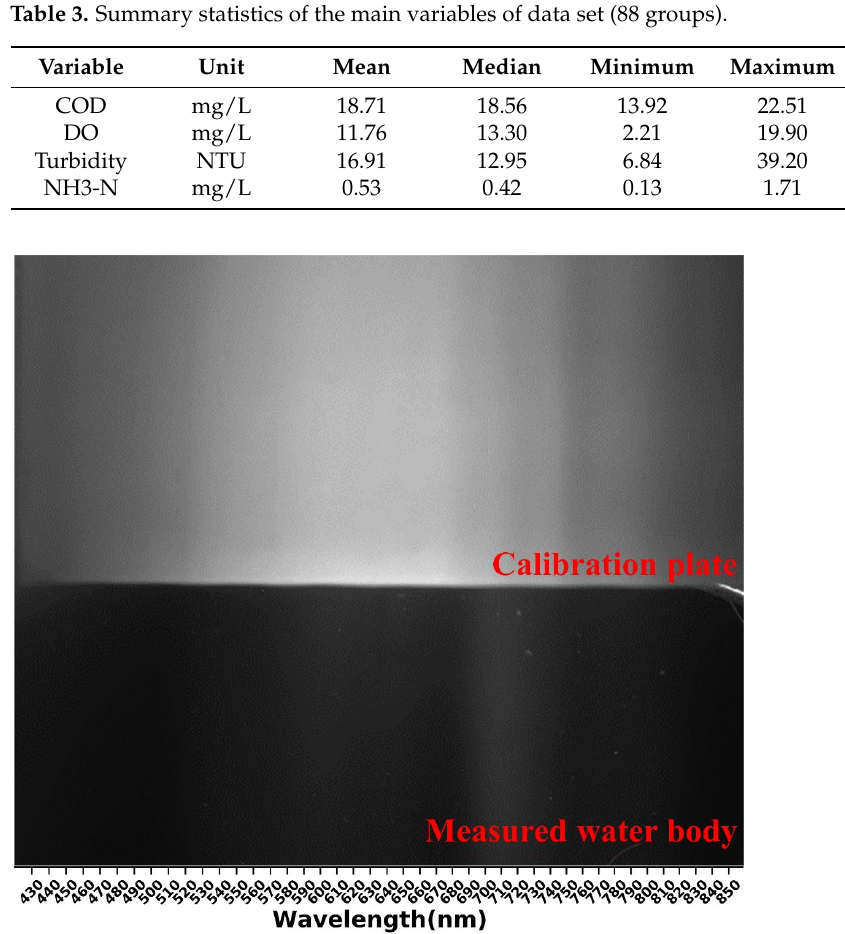
Figure 4. A hyperspectral image